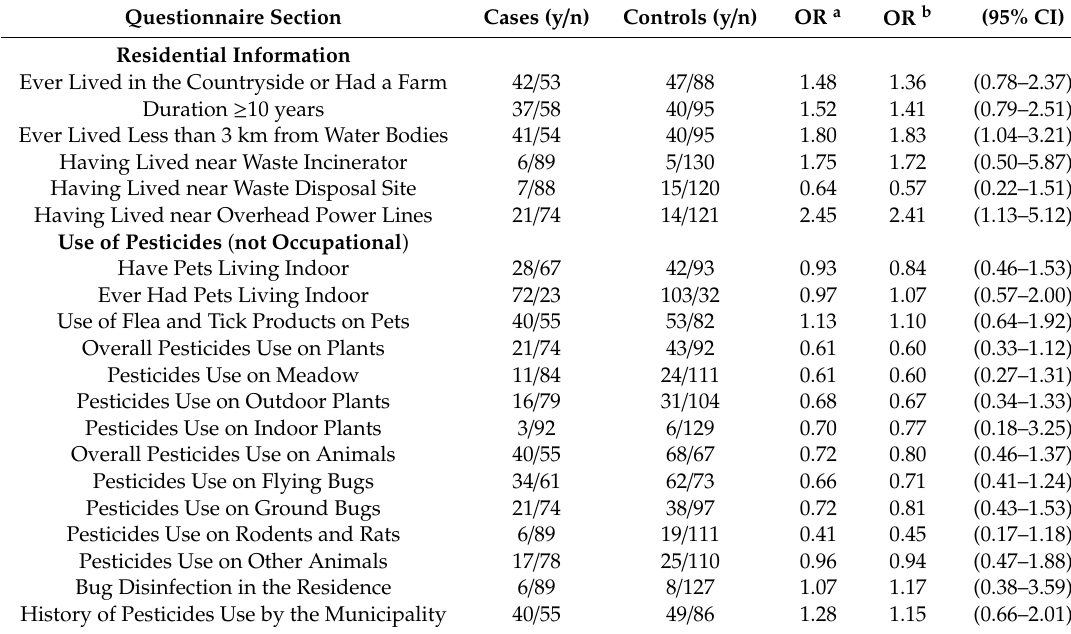
Table 3. Odds ratio (OR) with 95% confidence interval (CI) of ALS risk according residential information and non-occupational use of